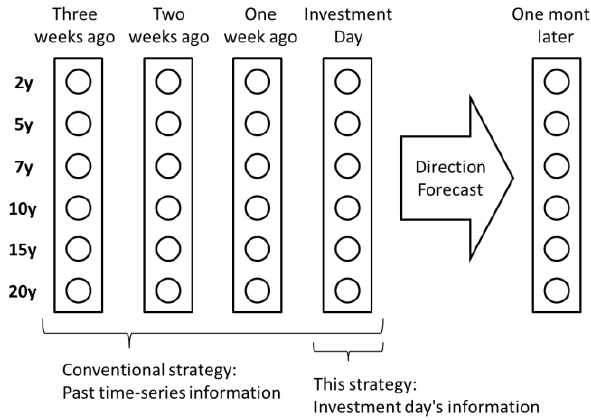
Figure 16. The differences in interest rate information used for each investment strategy.